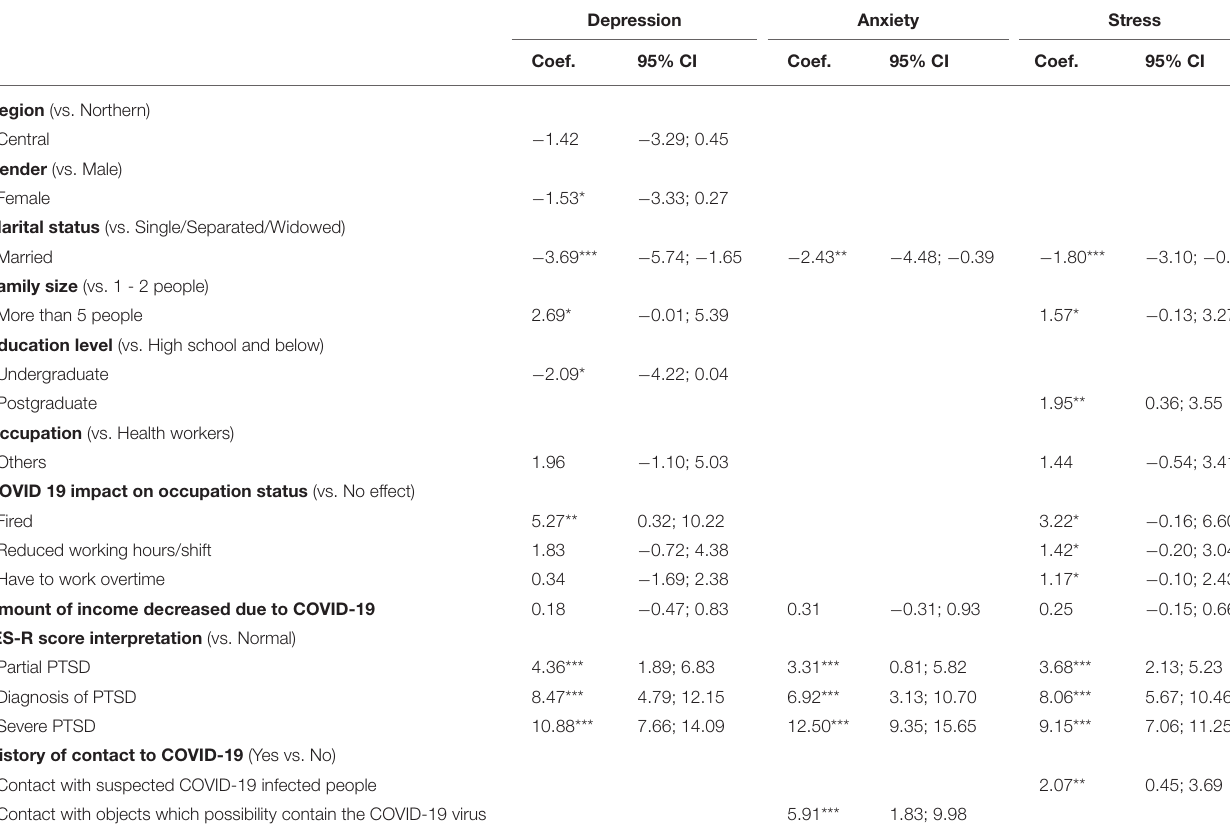
TABLE 4 | Associated factors with depression, anxiety and stress related to COVID 19 among Vietnamese. Depression Anxiety Stress Coef. 95% CI Coef. 95% CI Coef. 95%